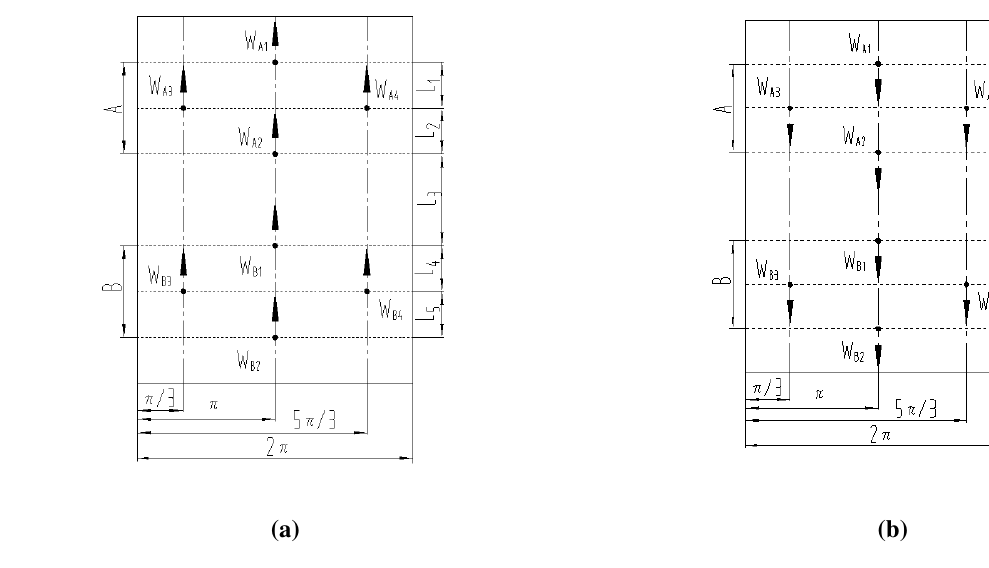
Fig. 4 The driving wheels walk up or down along the axis.